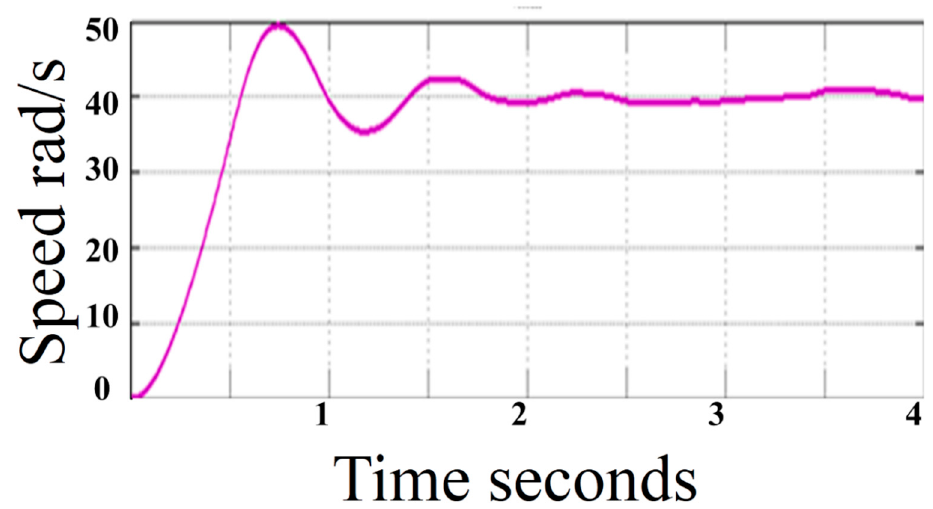
Figure 14. Simulation of the best result for ST2FDE with noise 0.7 FLC. Figure 15 represents the simulation of the best result, 4.52 × 10 − 01 This value can be seen in Table 5, and the simulation represents the simulation with noise of 0.9 in the controller using ST2FDE.